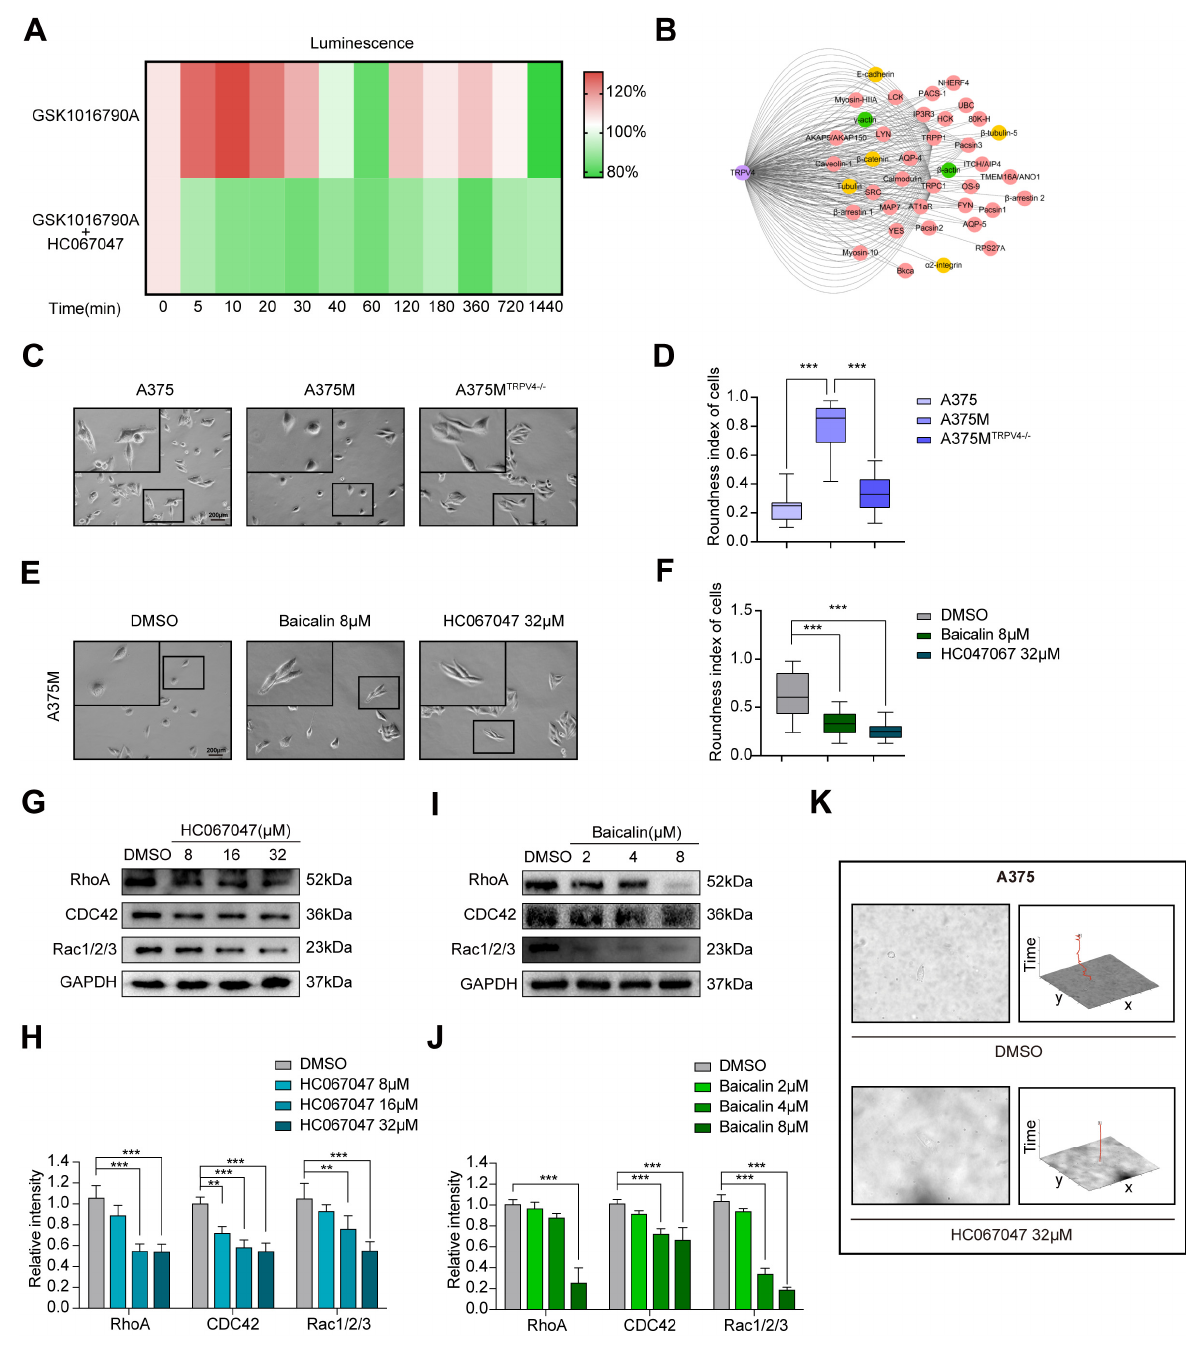
Figure 5. TRPV4 induces cell motility change through cytoskeletal rearrangement. ( A ) Luminescence intensive detection of ATP in A375 cells treated with GSK1016790A (above) and HC067047 (below). ( B ) Protein interaction network of TRPV4. ( C ) Representative bright-field images of A375, A375M, and A375 TRPV4 − / − cells. 200×. Scale bar, 200 μ m. ( D ) Cell morphology (roundness index) of A375, A375M, and A375 TRPV4 − / − cells. ( E ) Representative bright-field images of A375M cells treated with Baicalin or HC067047. 200×. Scale bar, 200 μ m. ( F ) Cell morphology (roundness index) of A375M, and A375M cells treated with Baicalin or HC067047. ( G , H ) Representative images of immunoblot analysis of RhoA, CDC42, and Rac1/2/3 in A375 cells treated with HC067047 for 24 h. ( I , J ) Representative images of immunoblot analysis of RhoA, CDC42, and Rac1/2/3 in A375 cells treated with Baicalin for 24 h. ( K ) Cell trajectories on phase contrast images (cell trajectories are marked in red). Data are expressed as means ± SD. ** p < 0.01, *** p <